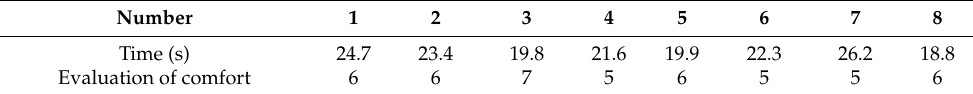
Table 5. Data of Experiment 2 (Key control).